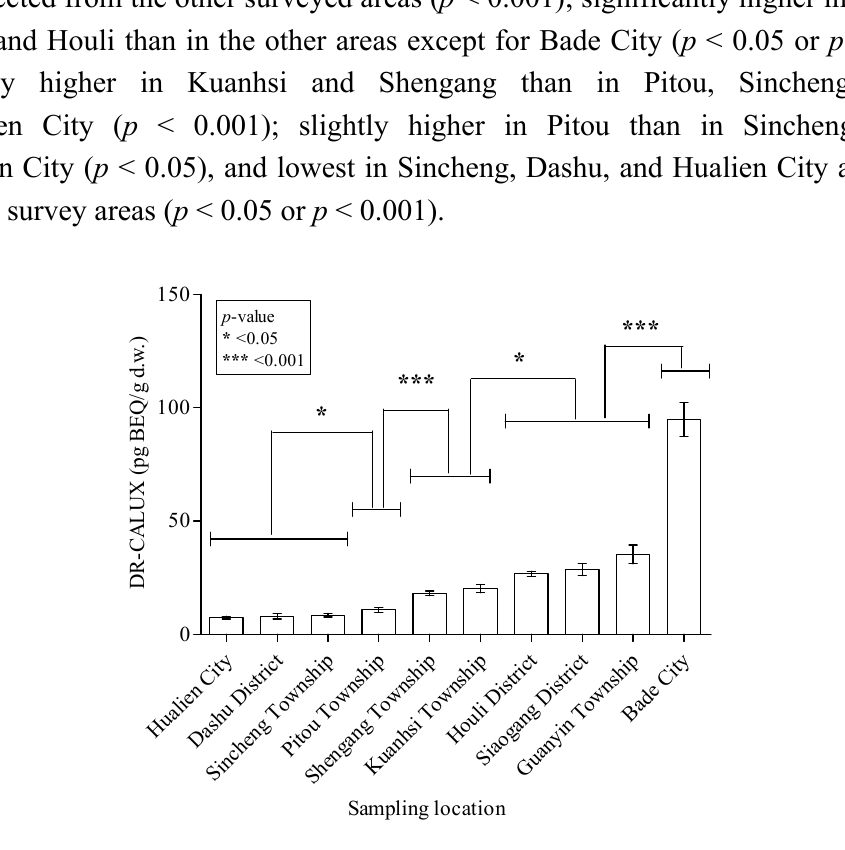
Figure 3. Dioxin concentrations are shown for soils of different brightness (three colors) (n = 685). Dioxin levels are similar in the three soils of different color and marginally significantly different between light and dark soils ( p =